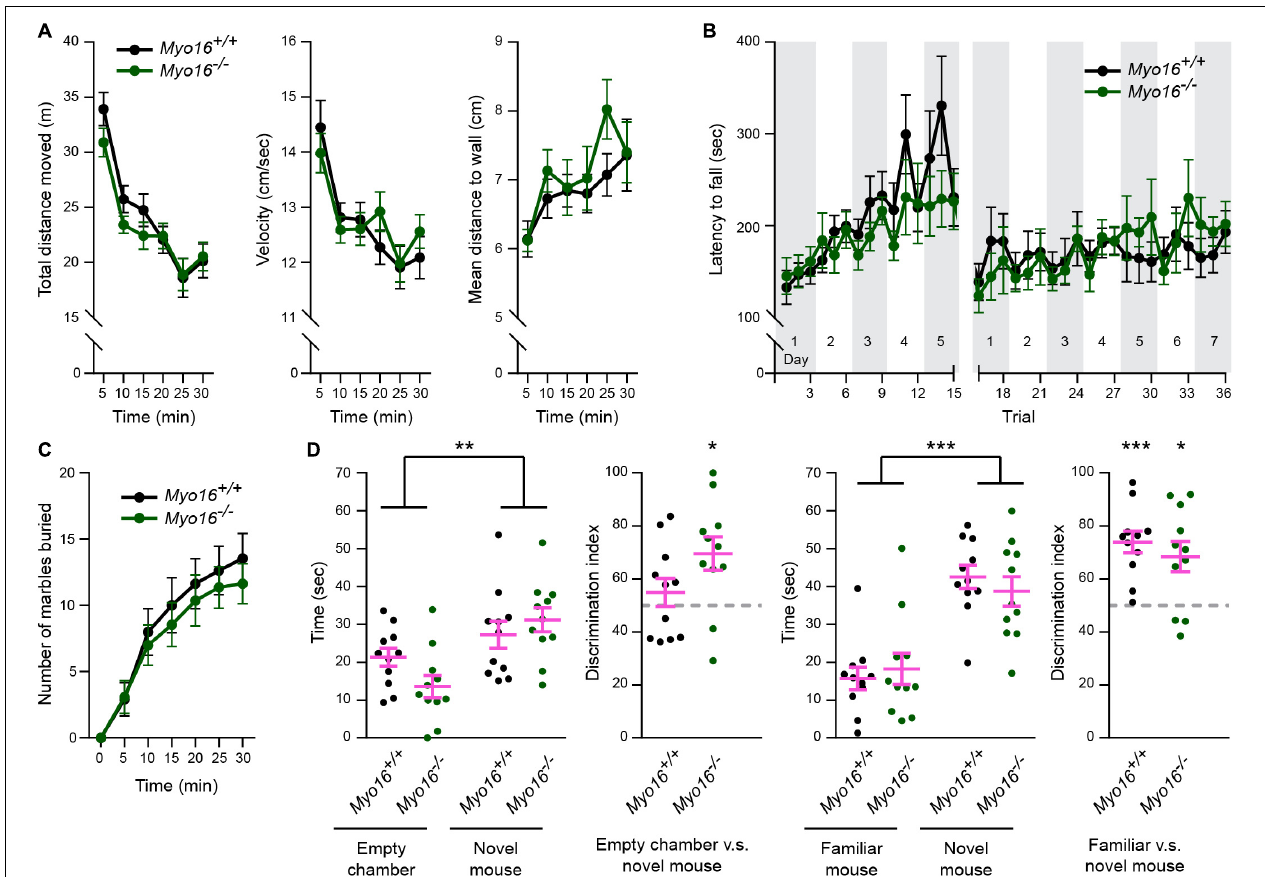
FIGURE 10 | Comparable performance of Myo16 em 3 knockout ( Myo16 − / − ) and Myo16 + / + littermate control mice in a behavior test survey. (A) In the open field test, both genotypes showed similar locomotor habituation to the paradigm as indicated by the decrease in distance moved (genotype: p = 0.42), decreased mean velocity (genotype: p = 0.88) and an increased mean distance to wall (less thigmotaxis) (genotype: p = 0.47) over a 30 min test duration. (B) Latency to fall from an accelerating rotarod revealed significant increase of duration over trials ( p < 0.001) with no effect of genotype ( p = 0.77). (C) Both genotypes show similar performance in marble burying ( p = 0.61). (D) Time exploring an empty cup vs. a novel mouse, or a familiar vs. a novel mouse during the first 2 min of a social recognition test. Mice spent more exploration time with the novel mouse vs. the empty cup ( p < 0.01, no effect of genotype: p = 0.17) and more time investigating the novel mouse vs. the familiar mouse (choice: p < 0.001, no effect of genotype: p = 0.82). The discrimination index showed a significant preference of Myo16 − / − but not the Myo16 + / + mice for the novel mouse over the empty chamber ( p < 0.05; p = 0.372, respectively) and a significant preference of both genotypes for the novel over the familiar mouse ( p < 0.05; p < 0.001, respectively). Values represent mean ± SEM ( A–D : repeated measures ANOVA, Discrimination index: one-sample t -test, test value: 50). Myo16 − / − and Myo16 + / + mice: n = 11 each. ∗ p < 0.05; ∗∗ p < 0.01; ∗∗∗ p < 0.001; ∗∗∗∗ p < 0.0001; n.s., not